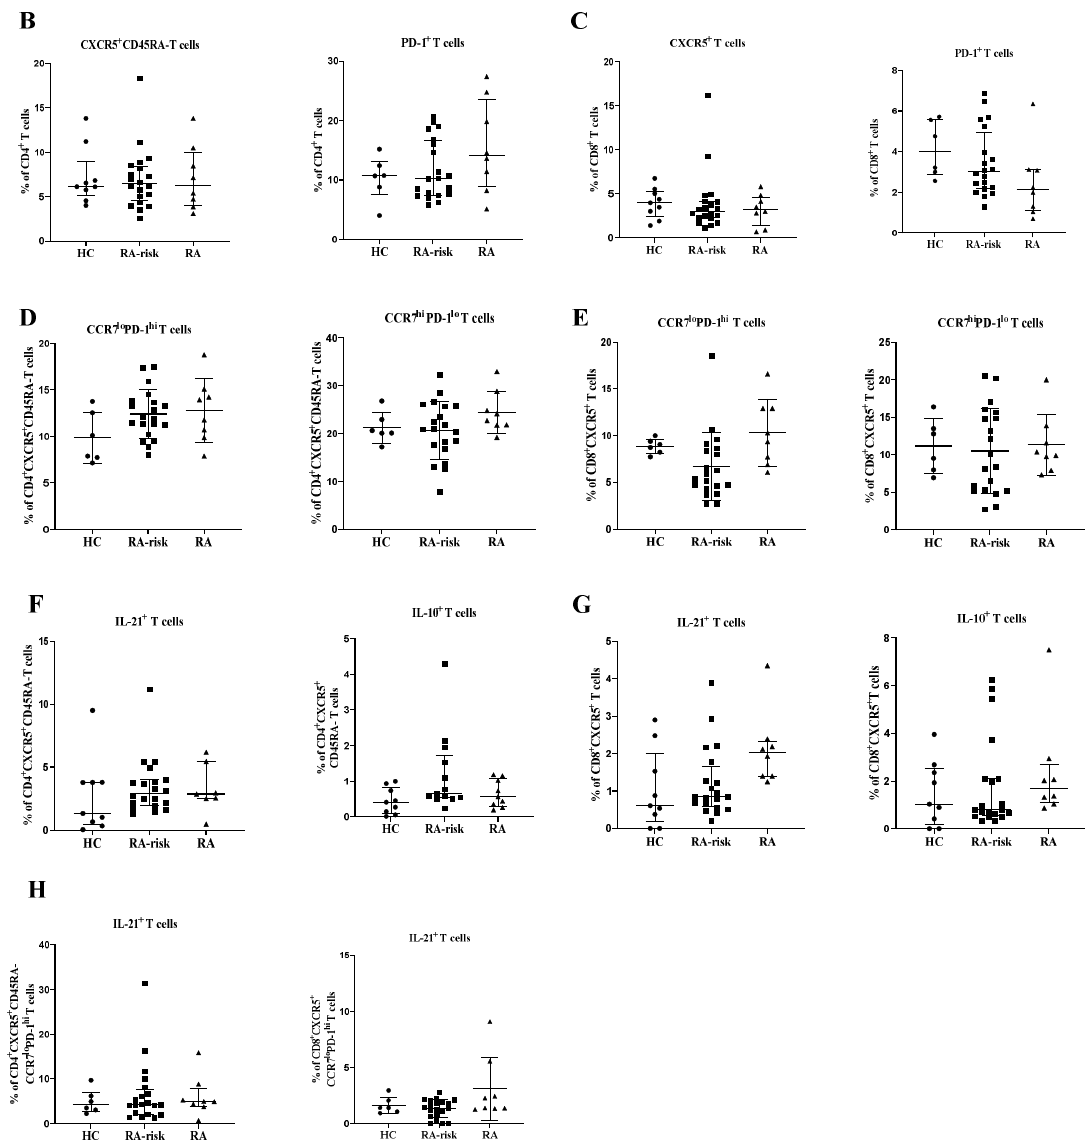
Figure 1. Analysis of circulating follicular helper T cells in peripheral blood samples. ( A ) Gating strategy for cTfh cells in PBMCs using markers for CD3, CD4, CD8, CXCR5, CCR7, PD-1, IL-21, and IL-10. After gating for single cells, CD4 + and CD8 + T cells were gated within the CD3 + population and further characterized. ( B , C ) The frequencies of CXCR5 + CD45RA-, and PD-1 + cells within CD4 + and the frequencies of CXCR5 + and PD-1 + cells within CD8 + T cells were analyzed in PBMC samples collected from healthy controls (HC, n = 9 for Figure 1B,C,F,G; otherwise, n = 6), RA-risk individuals (RA-risk, n = 20), and early RA patients (RA, n = 8). ( D , E ) The frequencies of blood CCR7 low PD1 high cTfh and CCR7 high PD1 low cTfh within the CD4 + CXCR5 + CD45RA- and CD8 + CXCR5 + populations are plotted for healthy controls (HC, n = 6), RA-risk individuals (RA-risk, n = 20), and early RA patients (RA, n = 8). ( F – H ) The frequencies of IL-21- and IL-10-producing cells within the indicated T-cell subsets are shown for healthy controls (HC, n = 6), RA-risk individuals (RA-risk n = 20), and early RA patients (RA, n = 8). Non-normally distributed data (Figure 1B–E) are presented as median with IQR, and normally distributed data ( F – H ) are presented as mean with SD. For statistical analysis, Kruskal–Wallis or one-way ANOVA (when appropriate) was performed. Non-parametric analysis was performed on study groups with n < 8. Shapiro–Wilk test was carried out to further confirm normality in this group. All symbols represent data from single individuals ( • healthy controls (HC); (cid:4) RA-risk individuals (RA-risk); (cid:78) early RA patients